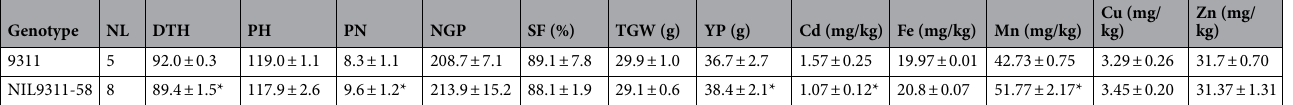
Table 5. Agronomic performance of improved 9311 (NIL9311-58) lines carrying OsHMA3-OsNramp5- OsNramp1 jap in the genetic background of 9311. NL: number of lines; DTH: days to heading; PH: plant height; PN: number of panicles per plant; NGP: number of grains per panicle; SF: spikelet fertility; TGW: 1000-grain weight; YP: yield per plant; Cd, Fe, Mn, Cu, Zn: Cd, Fe, Mn, Cu and Zn content in brown grains. *Significance at P <